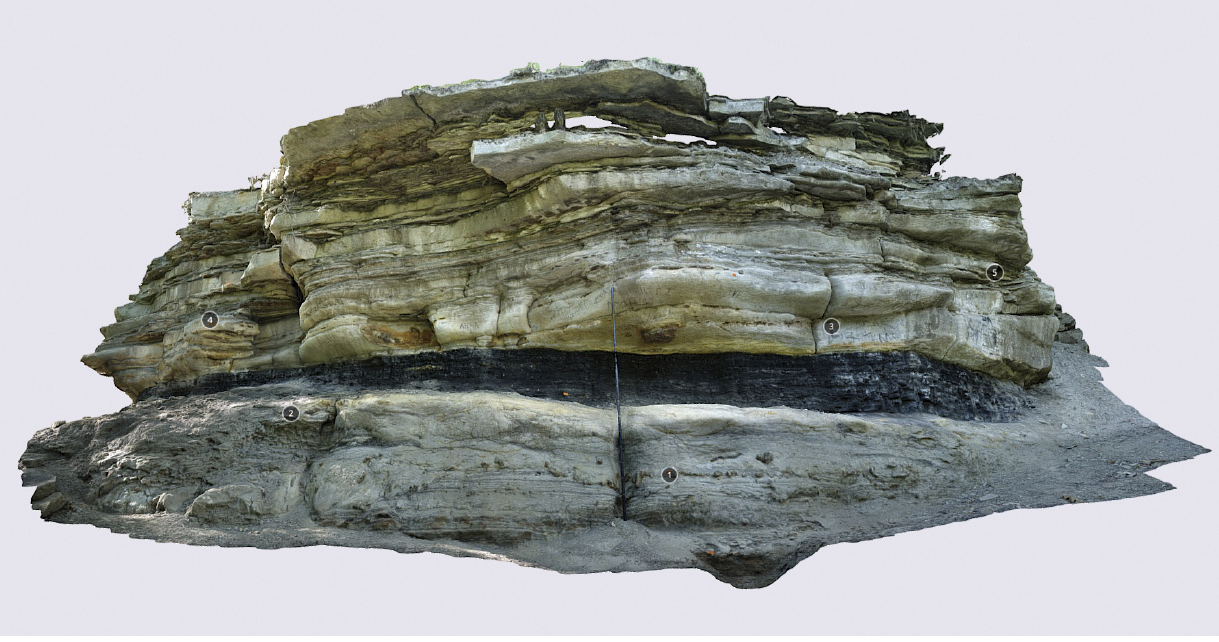
Figure 2. Virtual 3D outcrop model of American Vitrified 2 (staff has 10cm increments); annotation numbers correspond to other photo and sample data in the VFT. This is a still image of the fully manipulatable 3D virtual model of the outcrop, available via Sketchfab. This model is used in Parts 2–5 of the